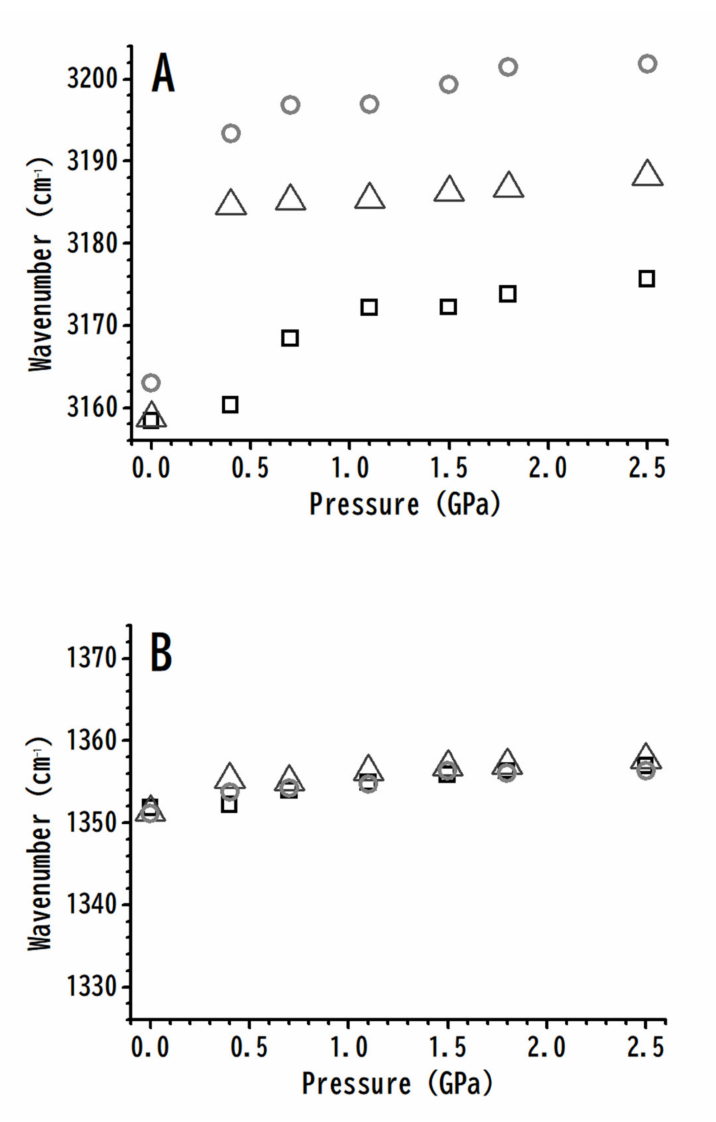
Figure 7. Pressure-dependence of the C–H stretching frequencies for ( A ) imidazolium C 4,5 –H and ( B ) anionic ν a SO 2 of pure [HMIM][NTf 2 ] (squares) and the [HMIM][NTF 2 ] / PVdF-co-HFP mixtures with 50 wt.% (triangles) and 10 wt.% (circles) of [HMIM][NTf 2